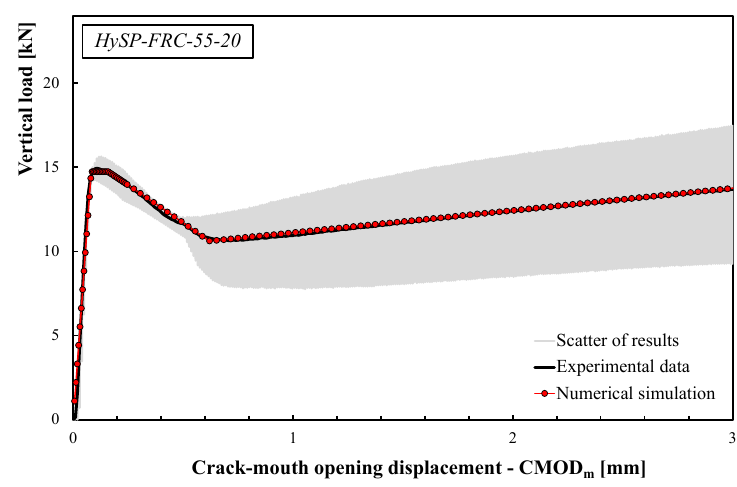
Figure 8. Experimental and numerical load–CMOD curves for the HySP-FRC-75-0 mixture.